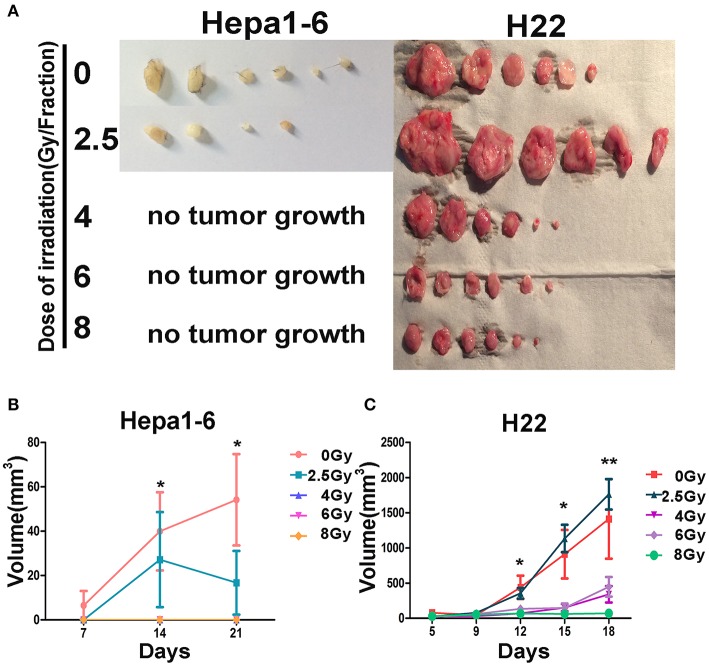
Effectiveness of the on-target vaccine created by hypofraction irradiation (IR) on off-target tumors was dose dependent. The allogeneic tumors on mouse hind limbs underwent different IR doses/fraction to create in situ vaccines. The antitumor immunity elicited by in situ vaccines was evaluated by observing the growth of the second tumor challenge on abdomen in both Hepa1-6/C57BL/6 and H22/Institute of Cancer Research (ICR) models. The second tumor challenge volume was measured weekly for Hepa1-6/C57BL/6 models and twice a week for H22/ICR models; and the tumor were calculated as length × width2/2. Results showed that all irradiated on-target tumors had an antitumor immunity effect on the second inoculated off-target tumors (A), except for H22 tumors irradiated with 2.5 Gy/fraction, in which the off-target tumors grew bigger than controls. The antitumor immunity effect of the in situ vaccines on the second inoculated off-target tumors (abscopal effect) was dose per fraction dependent (B,C). The higher the dose per fraction (>4 Gy) used, the stronger the antitumor immunity against the second tumor challenge developed. *P < 0.05, **P < 0.01.